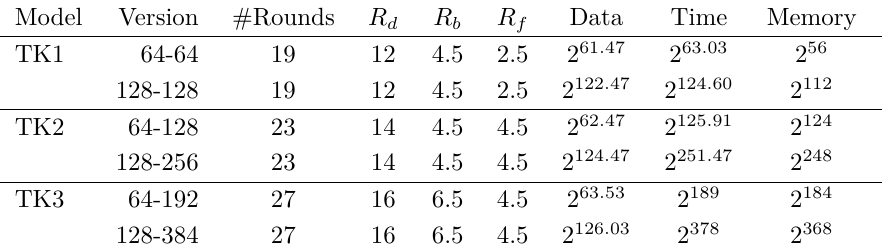
Table 3: Results of related-tweakey impossible differential attack on